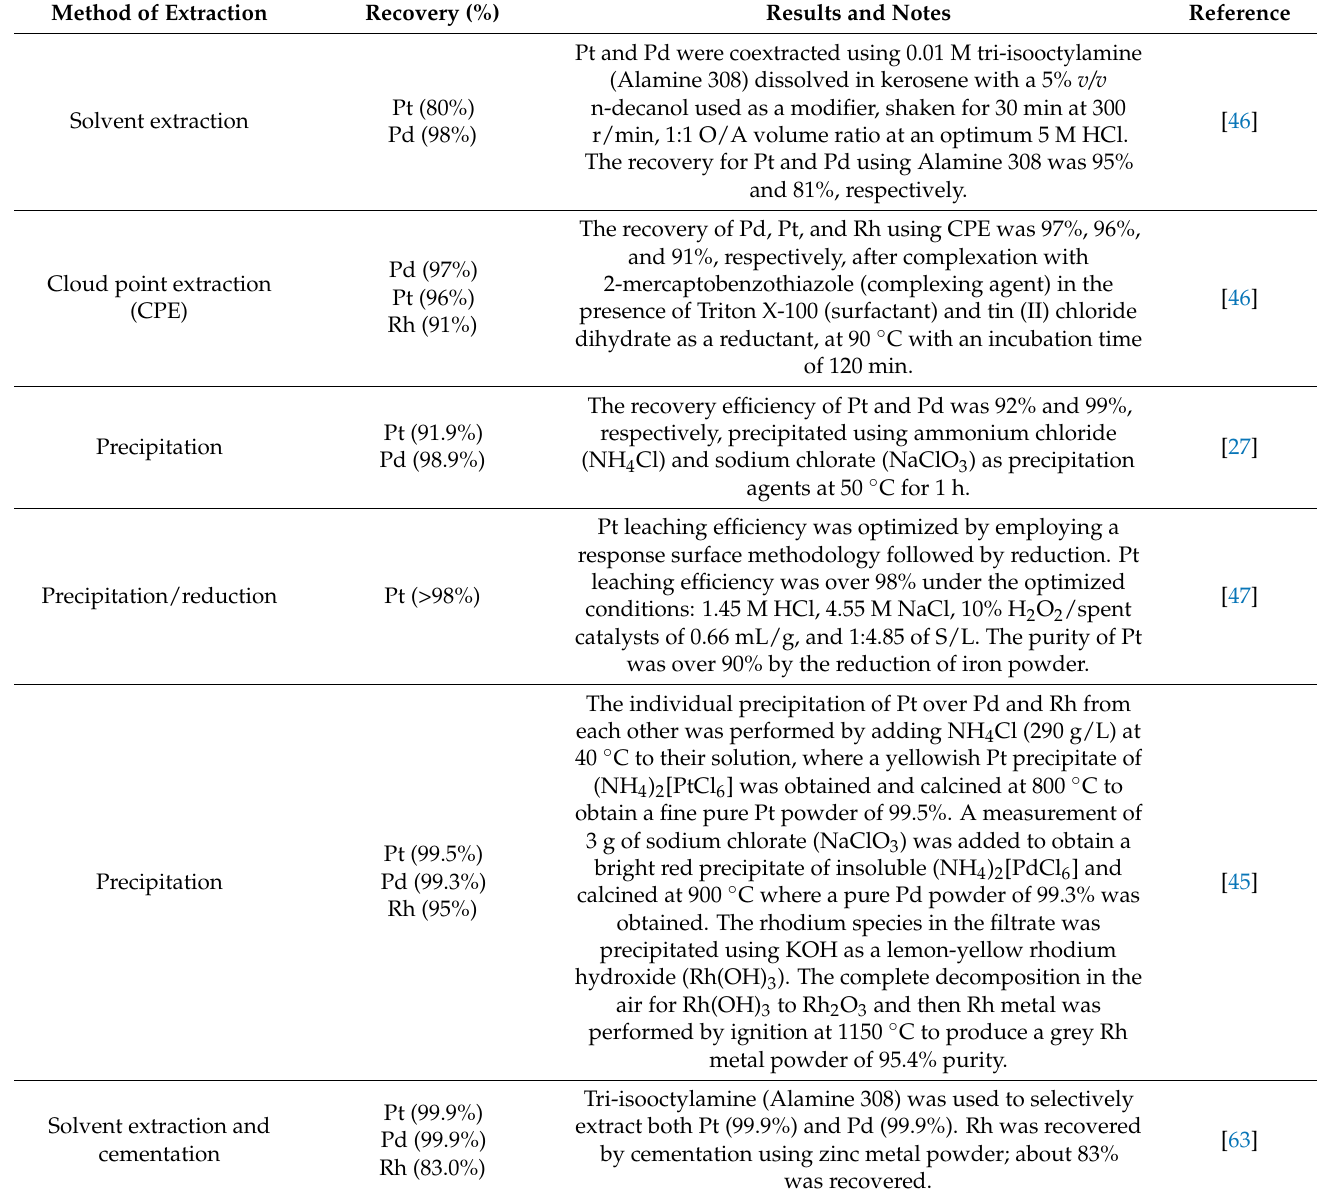
Table 4. Summary of recovery of PGMs from spent catalytic